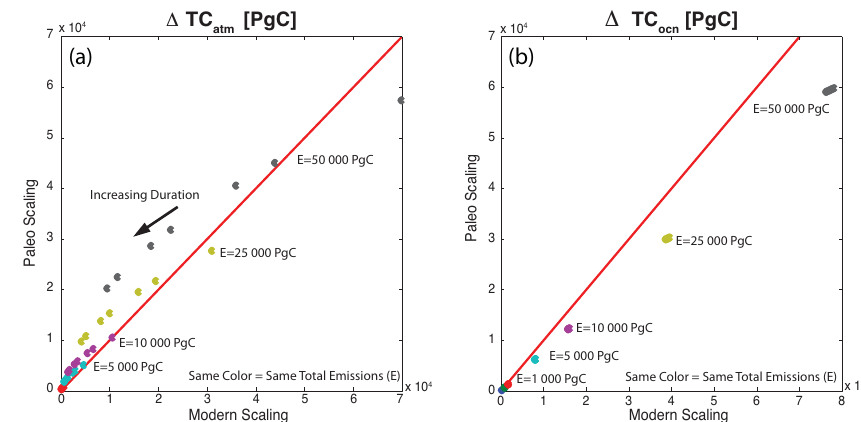
Figure 13. Correlation between peak perturbations for modern and paleo-scalings. (a) Total atmospheric carbon. (b) Total oceanic carbon. Same color denotes same total emissions.